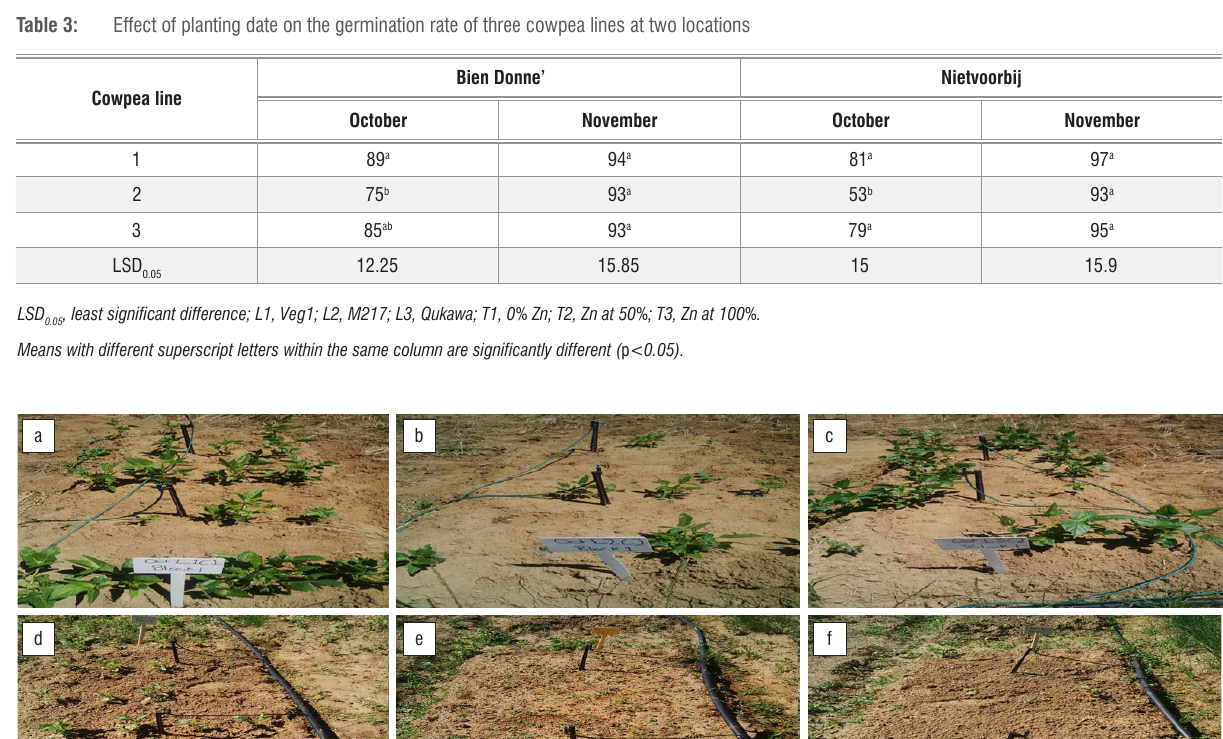
Table 3: Effect of planting date on the germination rate of three cowpea lines at two locations